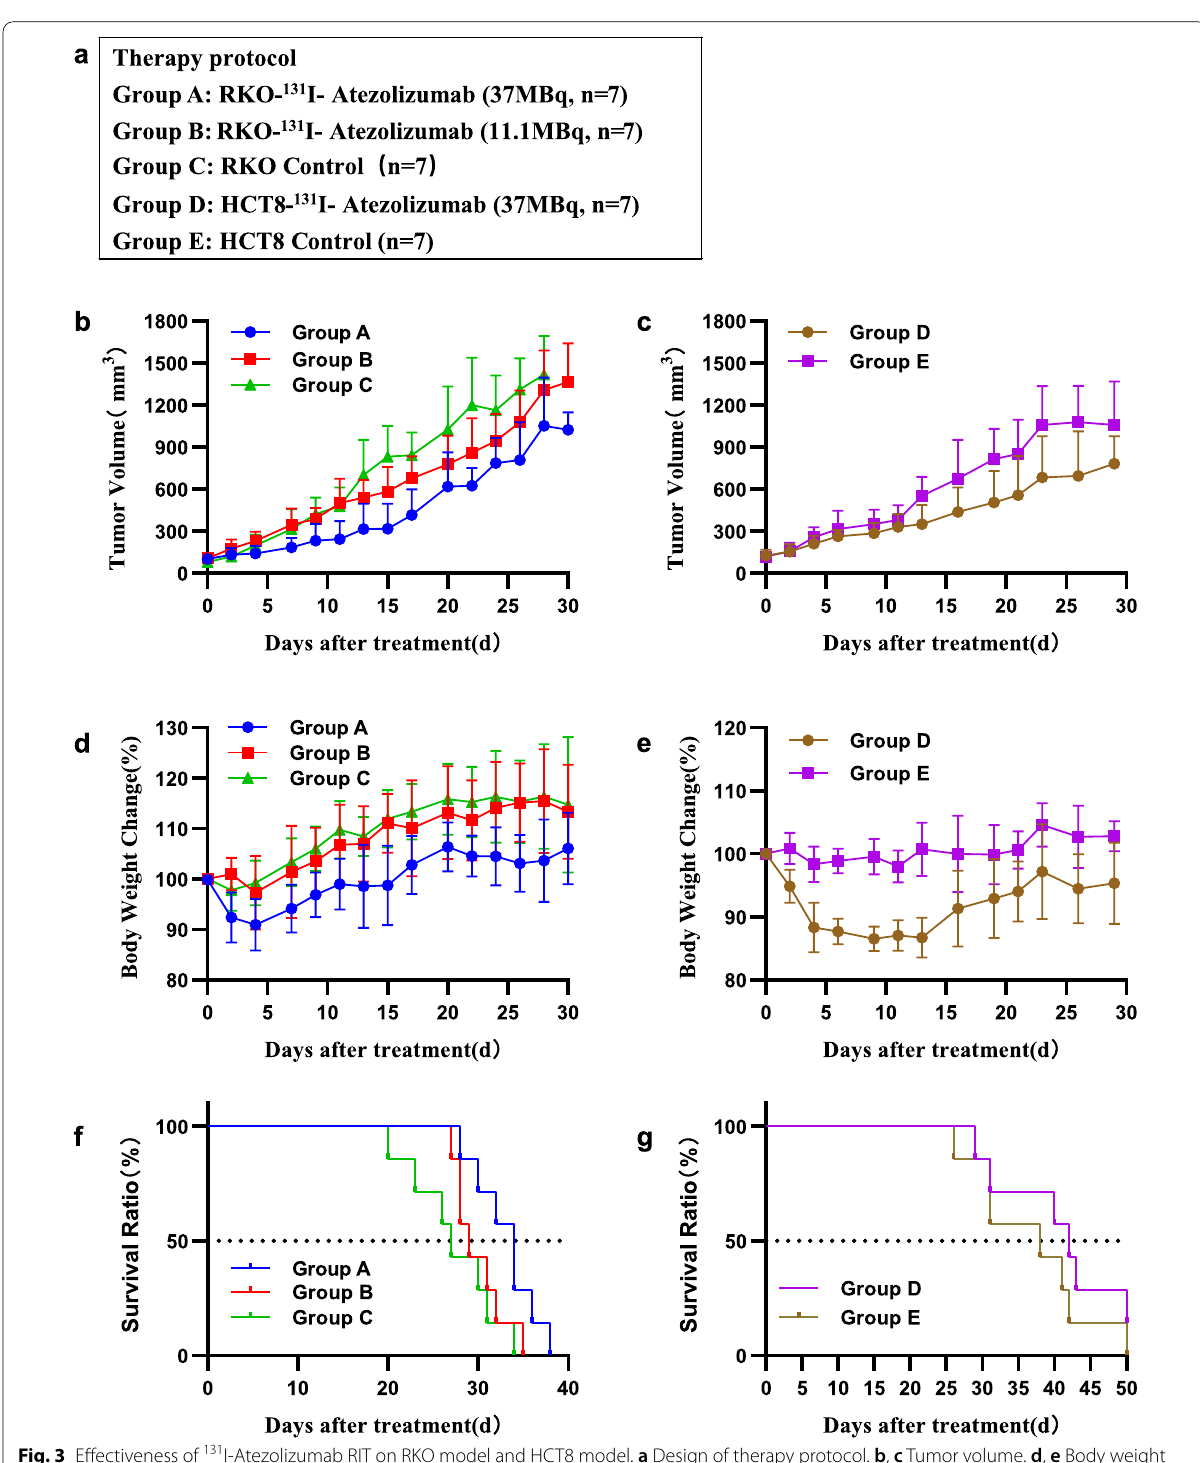
Fig. 3 Effectiveness of 131 I-Atezolizumab RIT on RKO model and HCT8 model. a Design of therapy protocol. b , c Tumor volume. d , e Body weight change. f , g Survival